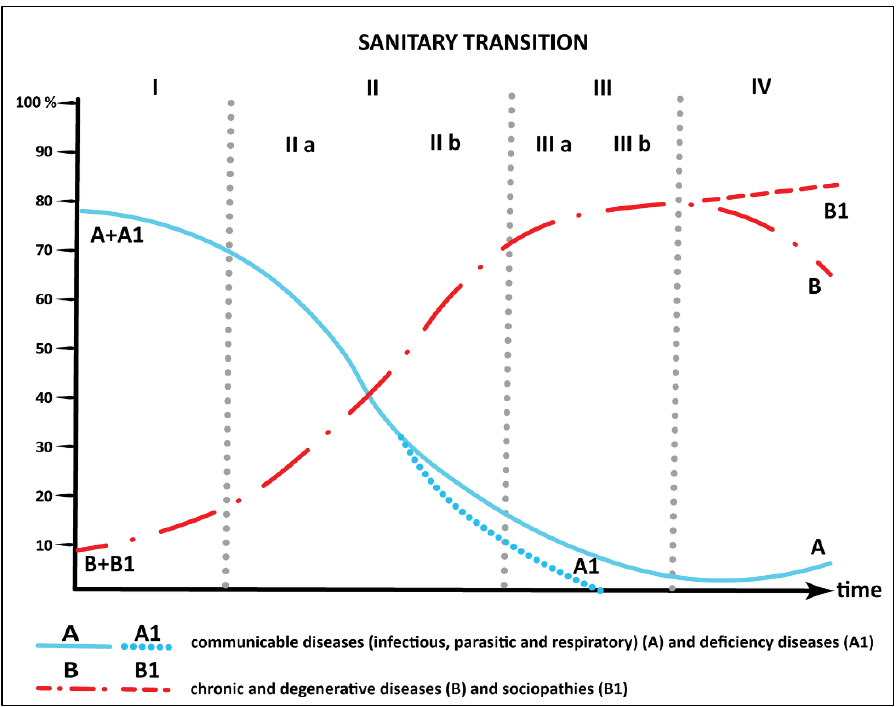
Figure 1. Phases of the epidemiological transition (Omran and Picheral, 1996). Source: Adaptation after: Picheral Henri (1996), La transition sanitaire dans le monde (World health transition).